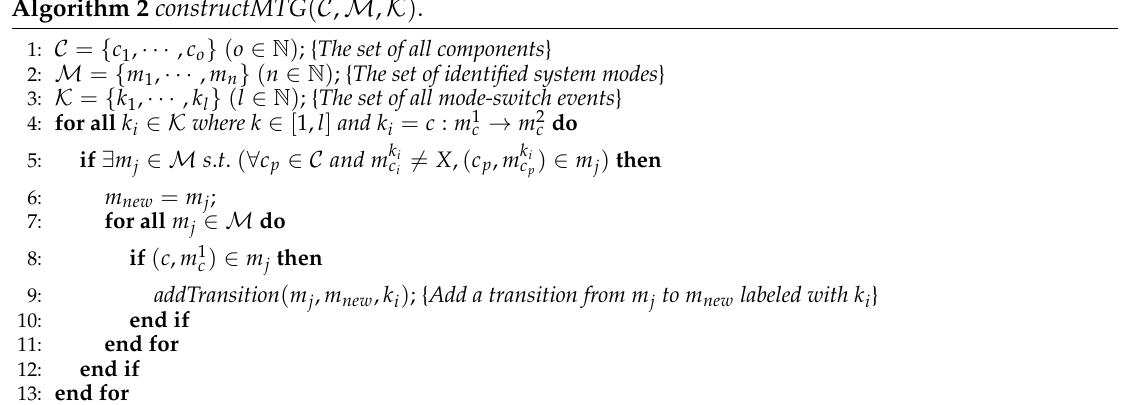
Algorithm 2 constructMTG ( C , M , K )